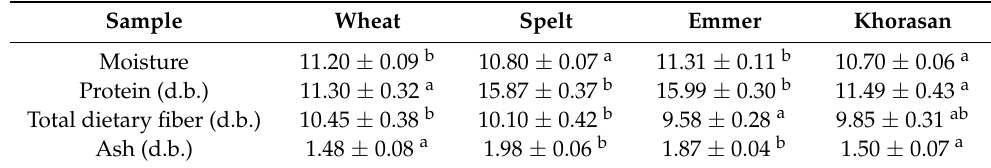
Table 1. Characteristics of wheat flour varieties. Sample Wheat Spelt Emmer Khorasan Moisture 11.20 ± 0.09 b Protein (d.b.) Total dietary fiber